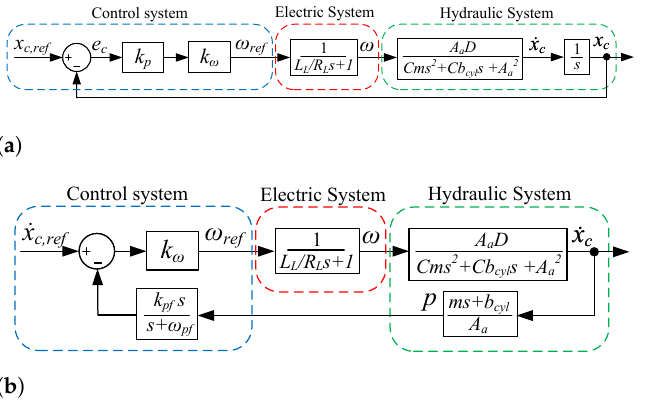
Figure 14. Simplified linear models used for tuning. ( a ) Linear model for tuning k p ; ( b ) Linear model for tuning k pf .